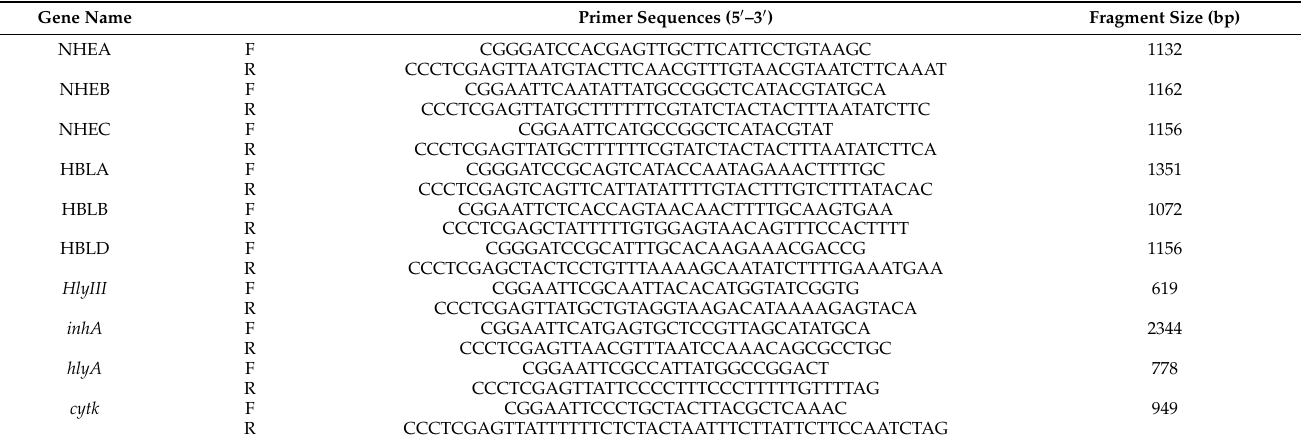
Table 1. The sequencing of virulence gene